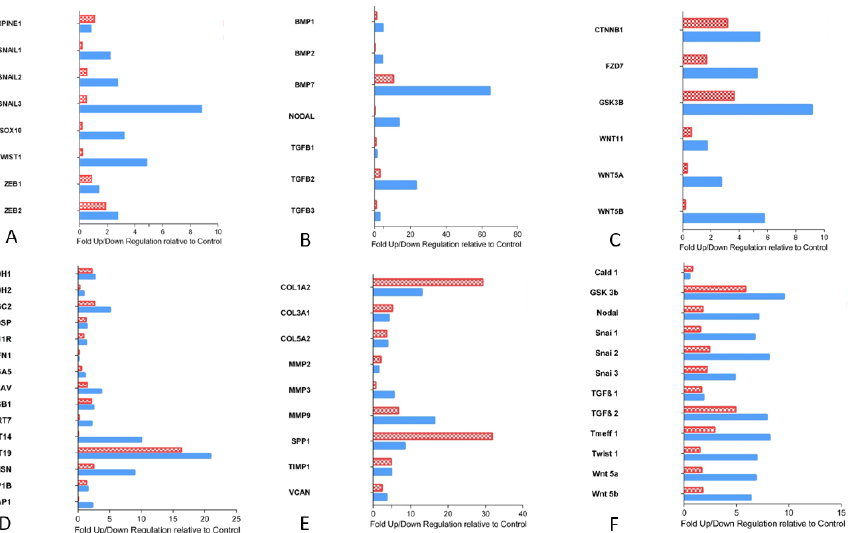
Figure 2. ( A ) Up- and downregulation of EMT transcription factors in CRLM with capsule (blue) and without capsule (red checked), diagrammed as multiple of liver tissue (control). ( B ) Up- and downregulation of TGF-ß superfamily in CRLM with capsule (blue) and without capsule (red checked), diagrammed as multiple of liver tissue (control). ( C ) Up- and downregulation of wnt pathway in CRLM with capsule (blue) and without capsule (red checked), diagrammed as multiple of liver tissue (control). ( D ) Up- and downregulation of relevant proteins for cell junctions in CRLM with capsule (blue) and without capsule (red checked), diagrammed as multiple of liver tissue (control). ( E ) Up- and downregulation of relevant gene products for collagen and matrix in CRLM with capsule (blue) and without capsule (red checked), diagrammed as multiple of liver tissue (control). ( F ) Up- and downregulation of 12 amplified genes in the custom arrays in CRLM with capsule (blue) and without capsule (red checked), diagrammed as multiple of liver tissue (control). Cancers 2023 , 15 , x FOR PEER REVIEW